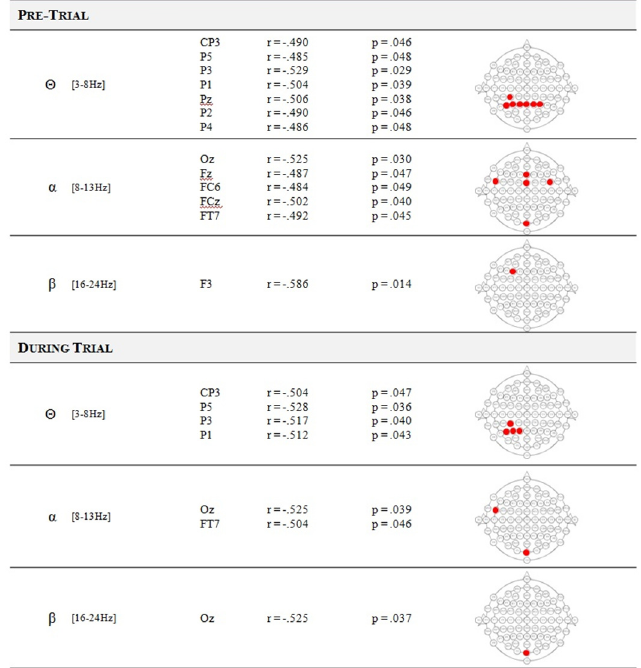
Fig 2. Correlations between MI-BCI performance and neurophysiological markers. Statistically significant correlations (before the correction for multiple comparisons) between MI-BCI performances and the average signal power recorded on the electrodes for the different frequency bands ( θ , α and β ) as a function of the period: pre-trial (from 2500ms to 500ms before the instruction) or during trial (from 500ms to 3500ms after the feedback start). None of these predictors reached significance after the correction for multiple comparisons.